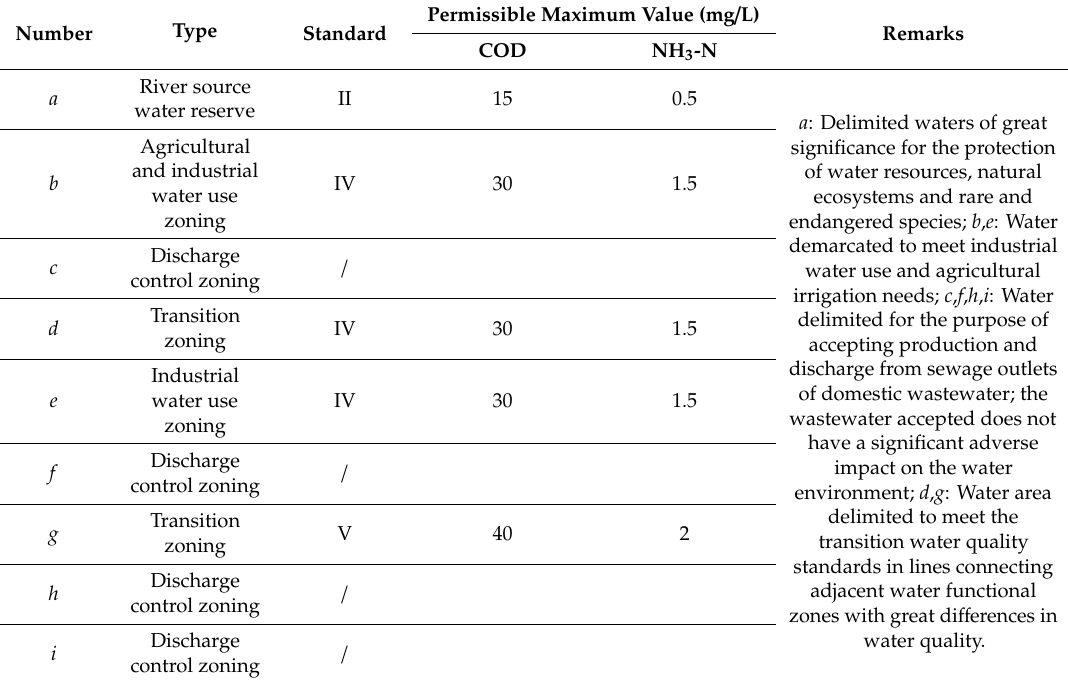
Table 1. Types of water function zone and water quality standards for each